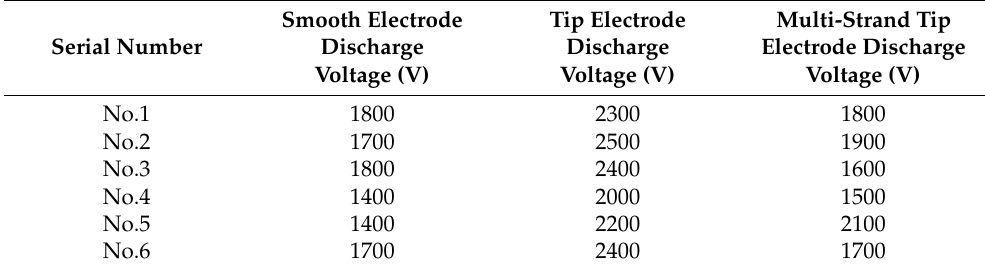
Table 2. Experimental data of tip electrode.